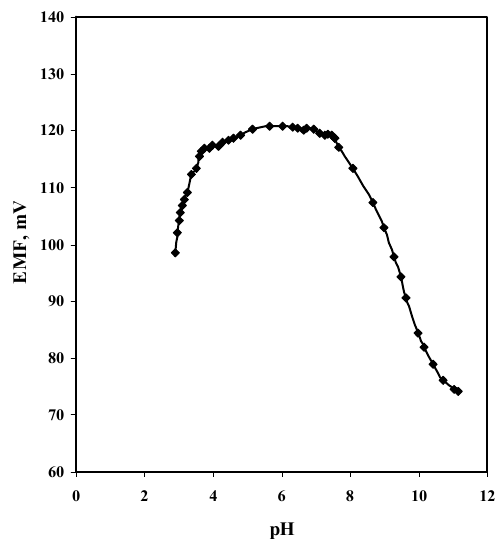
Figure 4. E ff ect of pH on the potentiometric response of [CoPC / TDMA + / o -NPOE] PVC membrane Figure 4. Effect of pH on the potentiometric response of [CoPC/TDMA + / o -NPOE] PVC membrane based sulfite sensor using 10 − 3 M sulfite based sulfite sensor using 10 − 3 M sulfite solution.